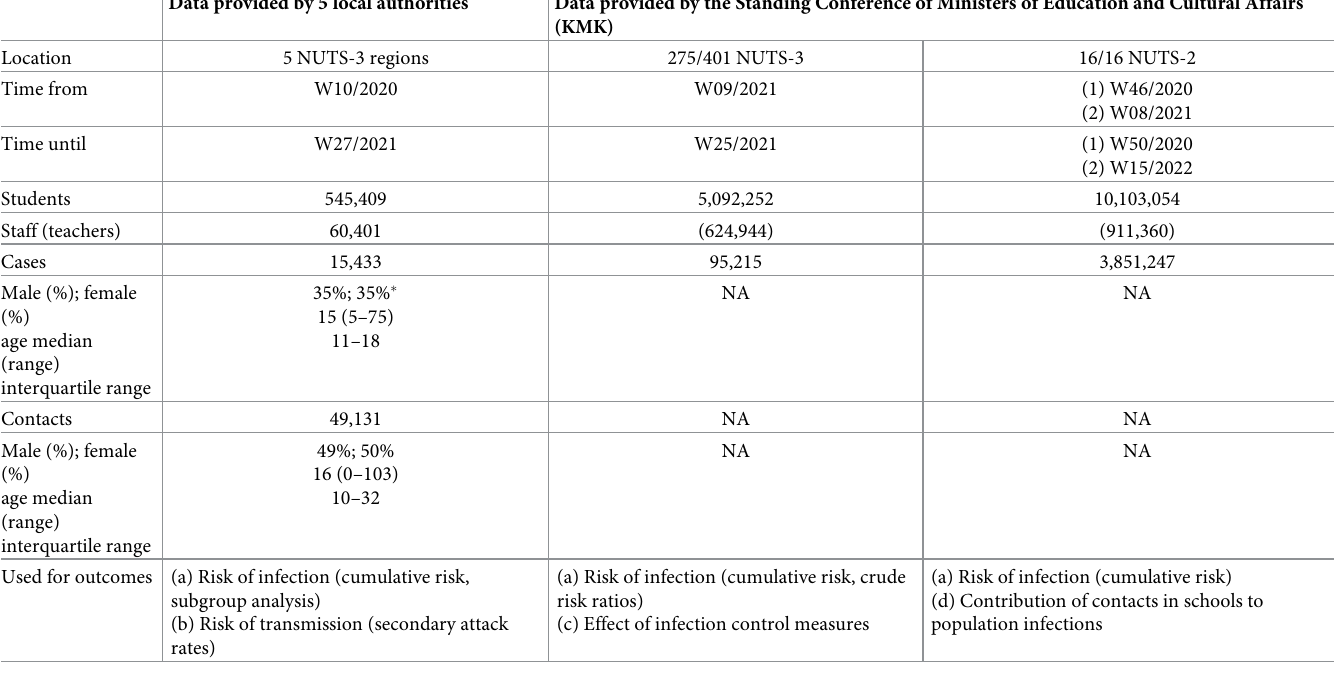
Table 2. Data sourced and outcomes. Data provided by 5 local